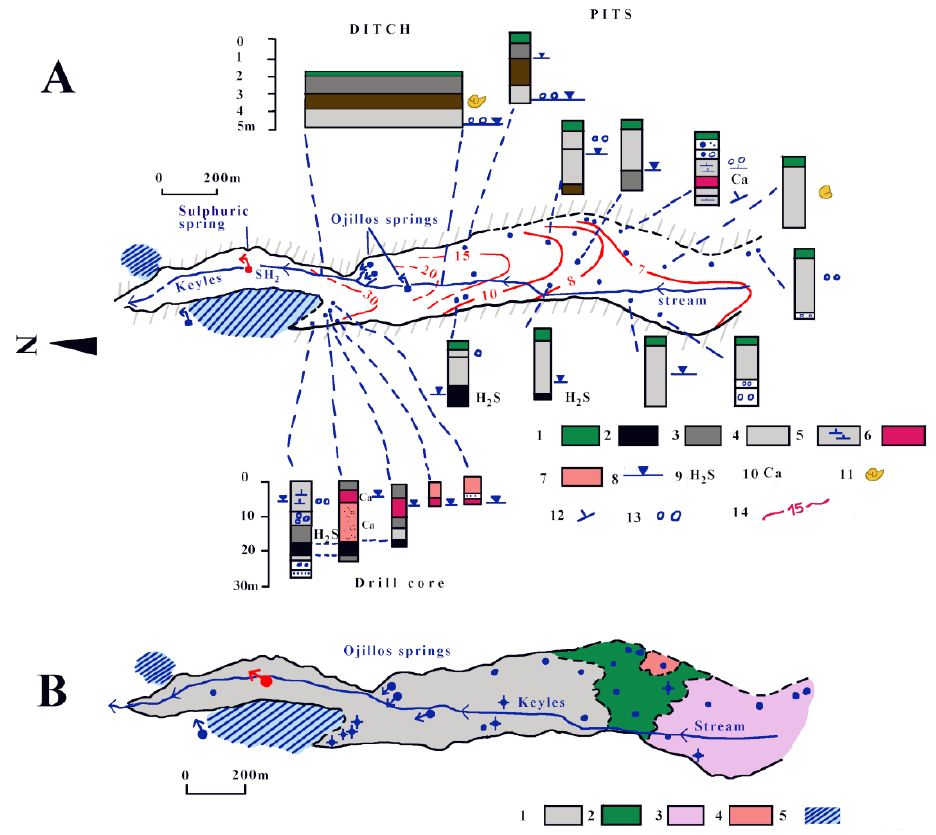
Figure 4. Geology of Quaternary aquifer. ( A ) (1) Soils; (2) peats; (3) clays and silts with much organic matter; (4) sandy silts; (5) calcareous silts; (6) calcareous tufa and tufa accumulations; (7) sands; (8) phreatic level; (9) sulphuric groundwater—H 2 S (10) calcareous sands or silts. Tufa levels, (11) gastropods; (12) plant remains; (13) levels of carbonate nodules or isolated nodules; (14) substrate depth (m). ( B ) (1) Peat and clays with much organic matter; (2) clayey silts; (3) sandy silts; (4) gravel; (5) calcareous tufas.